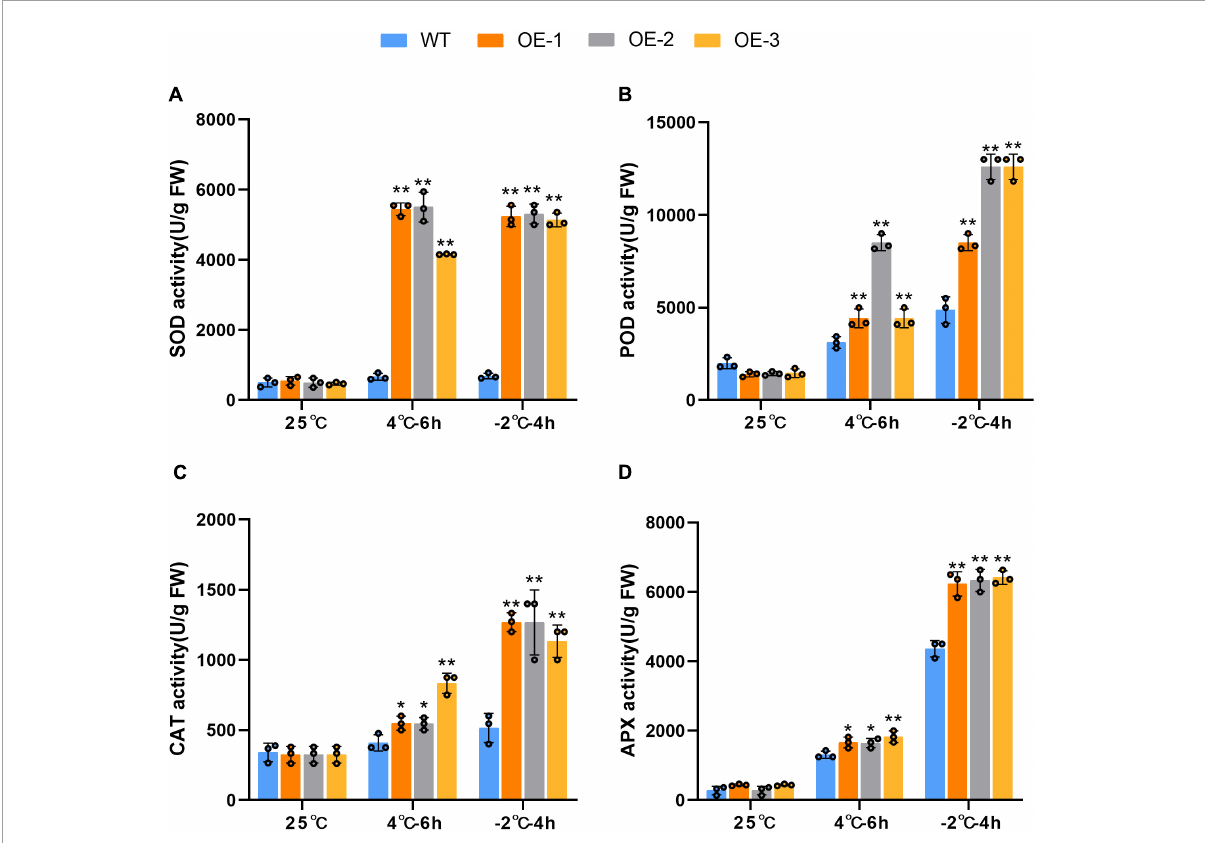
FIGURE6 Comparison of related enzymatic activities in leaves of transgenic and wild-type plants under normal and cold stress conditions. Comparison of SOD activity (A) , POD activity (B) , CAT activity (C) and APX activity (D) in leaves of transgenic and wild-type plants under normal and cold stress conditions. WT represents the wild-type tomato plants. OE-1, OE-2, and OE-3 represent three independent SiLEA4 transgenic tomato lines. Data are means ± SD of three replicates. Asterisk(s) indicate significant difference between the wild-type and transgenic plants: * P < 0.05 and ** P <